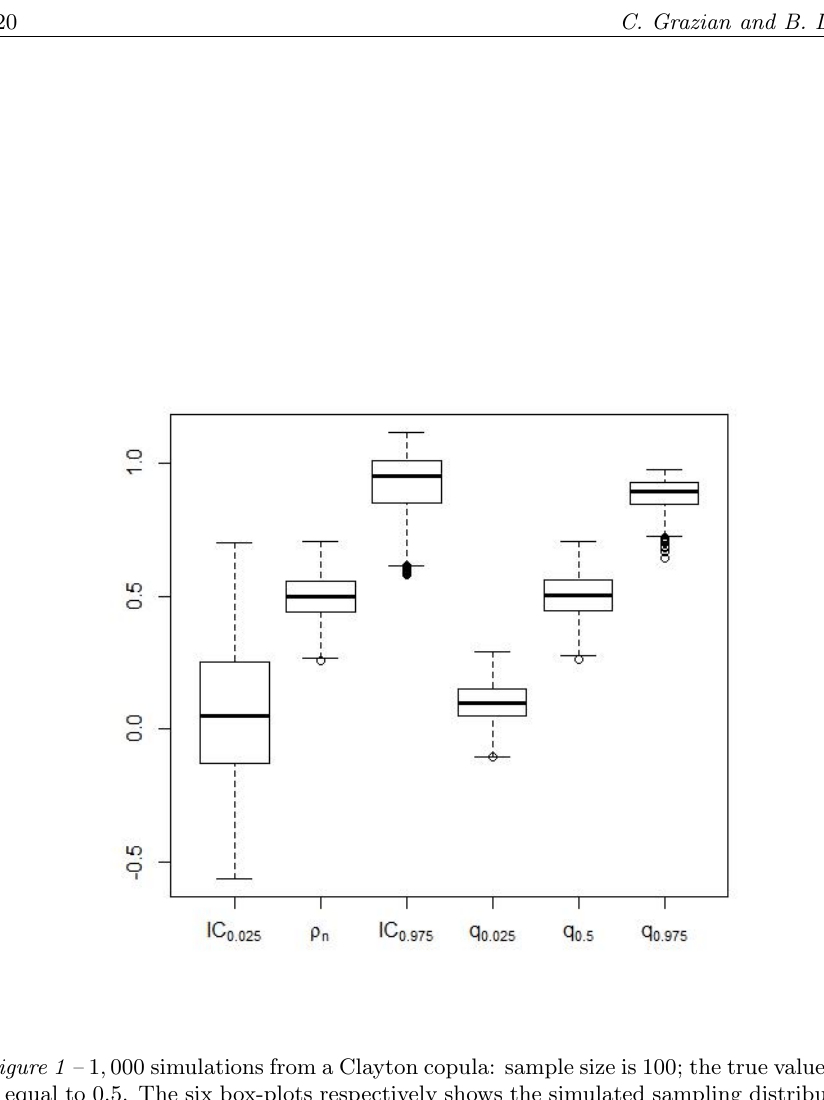
Figure 1 { 1 , 000 simulations from a Clayton copula: sample size is 100; the true value of ρ is equal to 0 . 5. The six box-plots respectively shows the simulated sampling distribution of: i) the lower limit of the equal-tail con(cid:12)dence interval with nominal coverage set at 0 . 95, ii) the point estimate ρ n , iii) the upper limit of the equal-tail con(cid:12)dence interval with nominal coverage set at 0 . 95. iv) the 2 . 5-th v) the 50-th and vi) the 95-th quantile of the approximate posterior